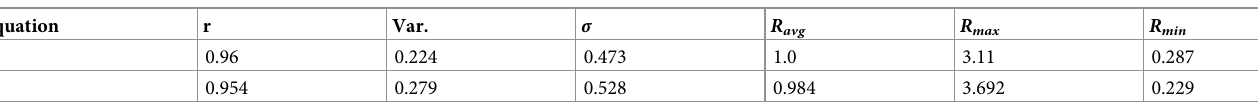
Table 3. Statistical results used in Eqs